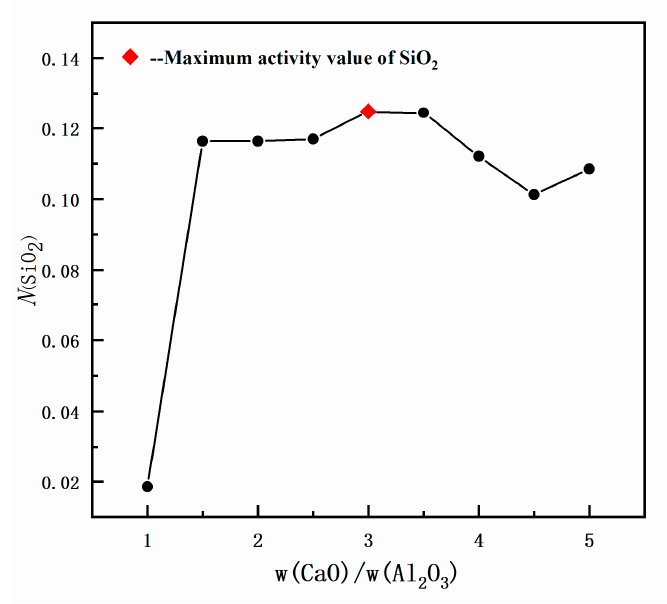
Figure 5. Model predicted values: effect of w(CaO)/w(Al 2 O 3 ) on SiO 2 activity in slag.